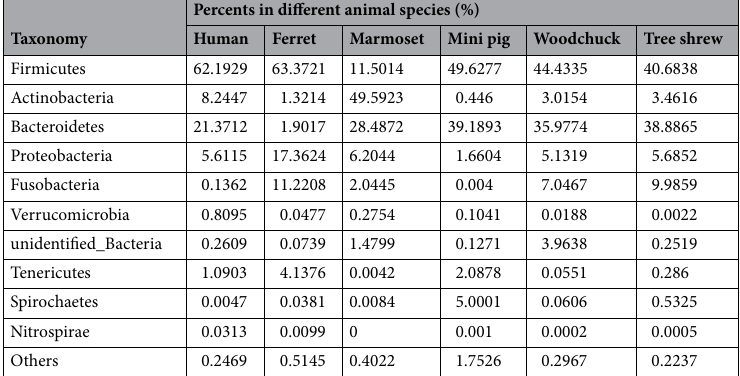
Table 1. Top 10 phyla in the microbiota of human and animals.